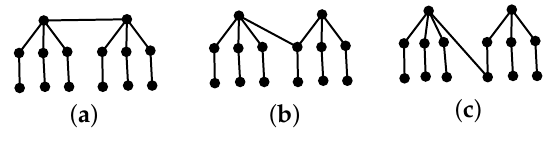
Figure 5. ( a ) Tree F 2 ; ( b ) tree F 3 ; ( c ) tree F 4